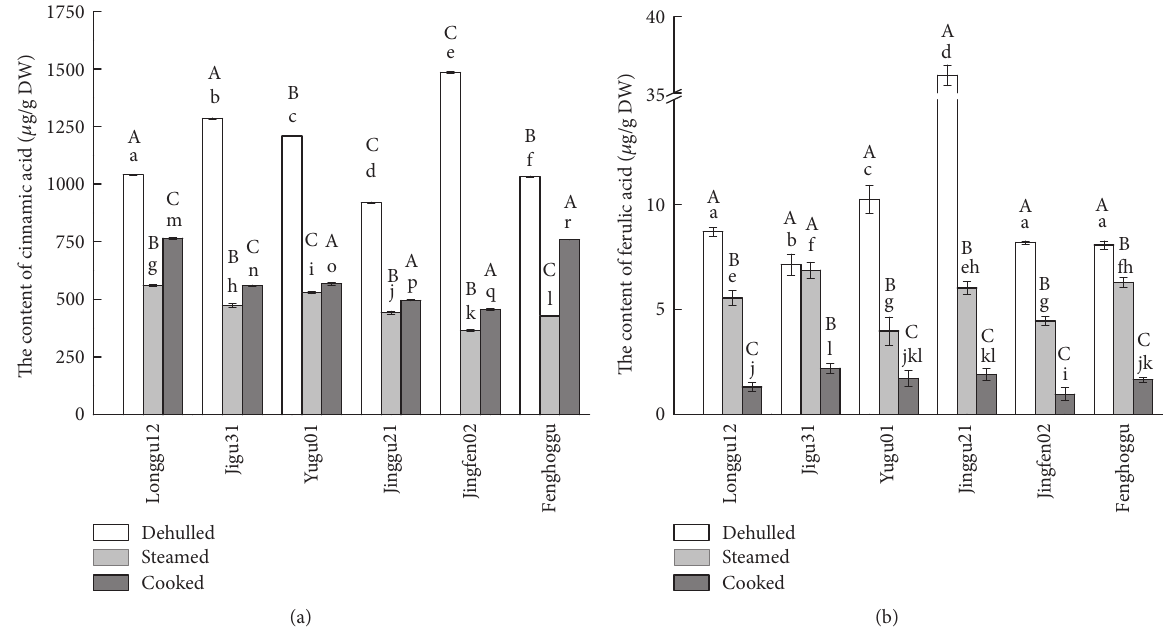
Figure 2: (a) The cinnamic acid of 6 cultivars of foxtail millet with different treatment. Error bars represent the standard deviation ( ± SD). The different uppercase letters (A–C) indicate significant differences within different processing methods of the same cultivar ( 𝑃 < 0.05 ). The different lowercase letters (a–r) indicate significant differences within different cultivars with the same treatment ( 𝑃 < 0.05 ). (b) The ferulic acid of 6 cultivars of foxtail millet with different treatment. Error bars represent the standard deviation ( ± SD). The different uppercase letters (A–C) indicate significant differences within different processing methods of the same cultivar ( 𝑃 < 0.05 ). The different lowercase letters (a–l) indicate significant differences within different cultivars with the same treatment ( 𝑃 < 0.05 ).